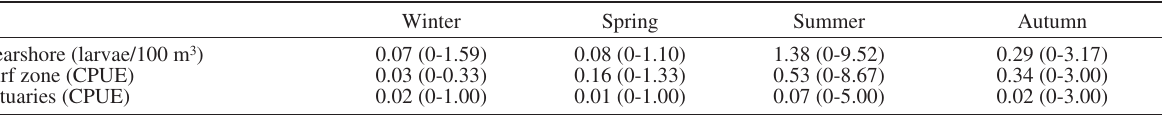
Table 3. – Seasonal occurrence of early developmental stages of Solea turbynei in the nearshore (2005-2007 and 2010-2012), surf zone (2010- 2012) and estuaries (2010-2012). Values represent the mean and range in parentheses.